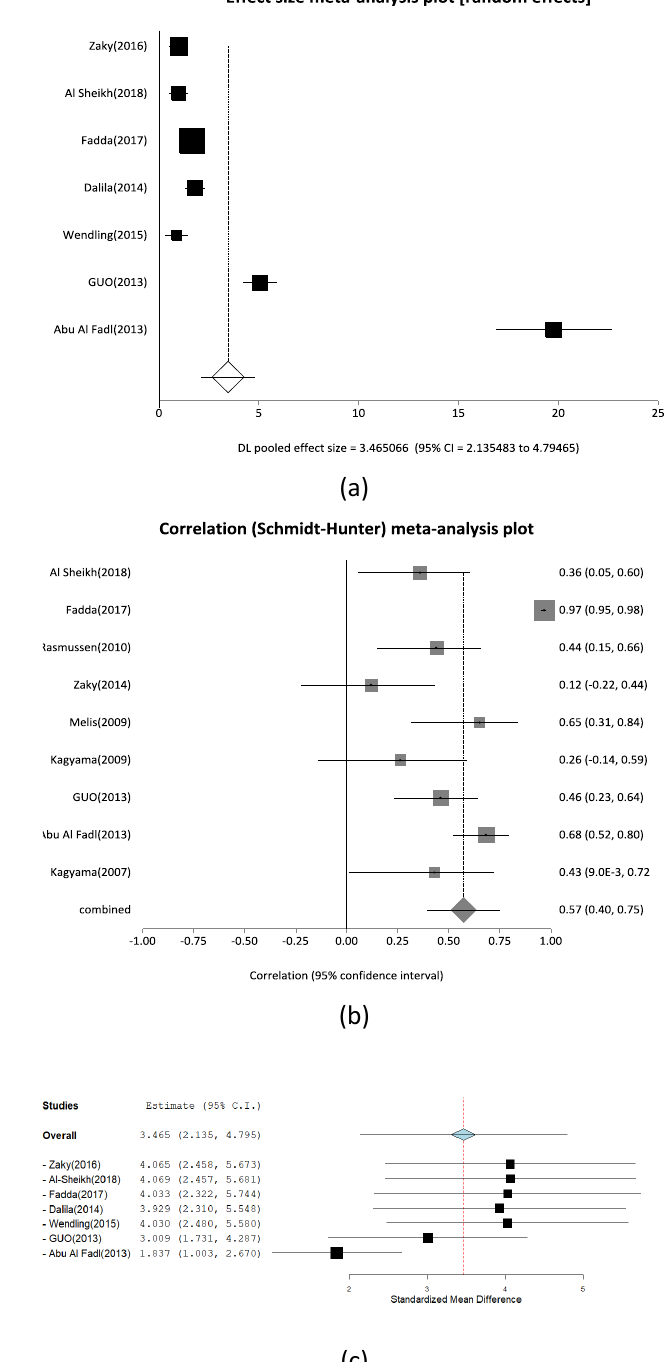
Figure 2 : Forest plot of the circulating IL-23 level in RA and controls. (A): standardized mean difference (SMD) of the circulating IL-23 level in RA and controls. (B): correlation coefficients between interleukin-23 levels and the activity of rheumatoid arthritis based on DAS28. (C): leave-one-out meta-analysis with random effect for standard mean difference in serum or plasma IL-23 levels in the rheumatoid patients vs.